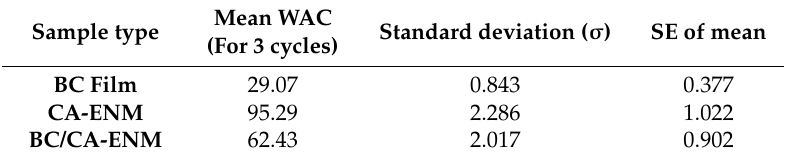
Table 3. Statistical values for water absorbance capacity.